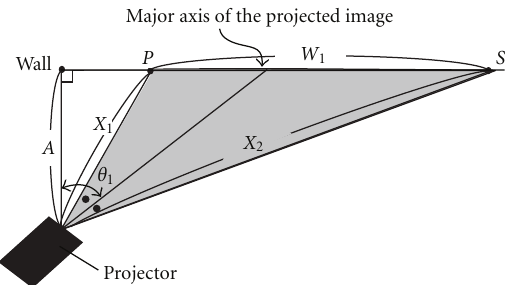
Figure 11: Configuration of image projected at a tilt.